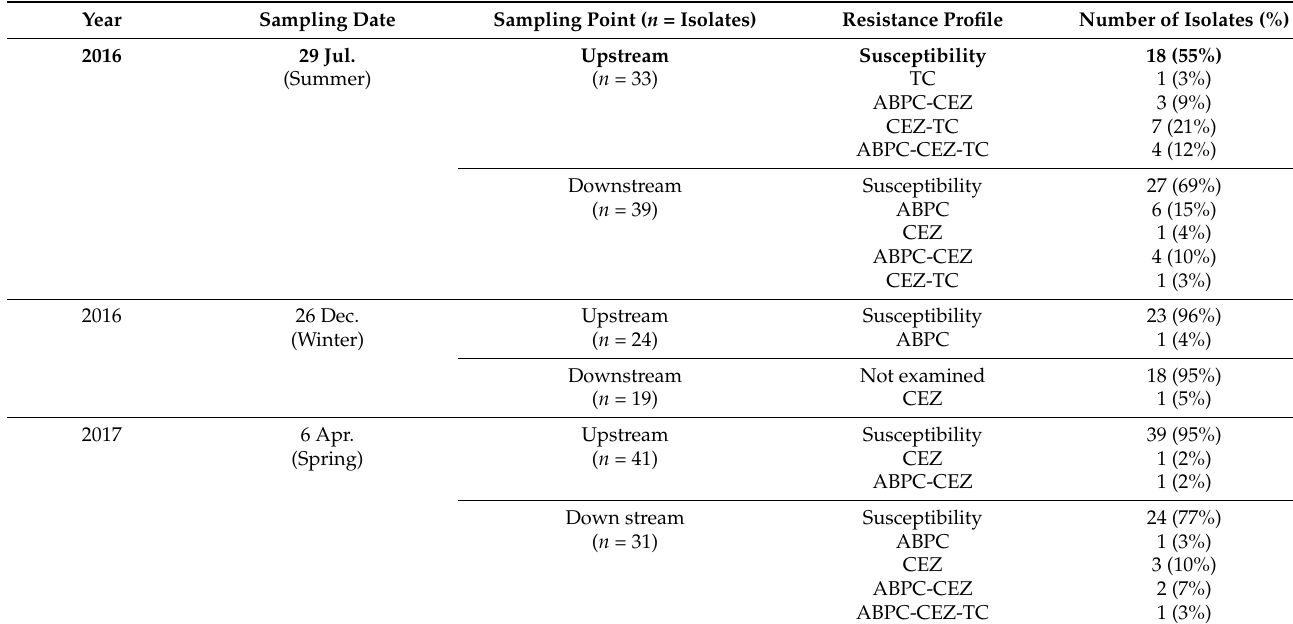
Table 4. Patterns of antibiotic resistance